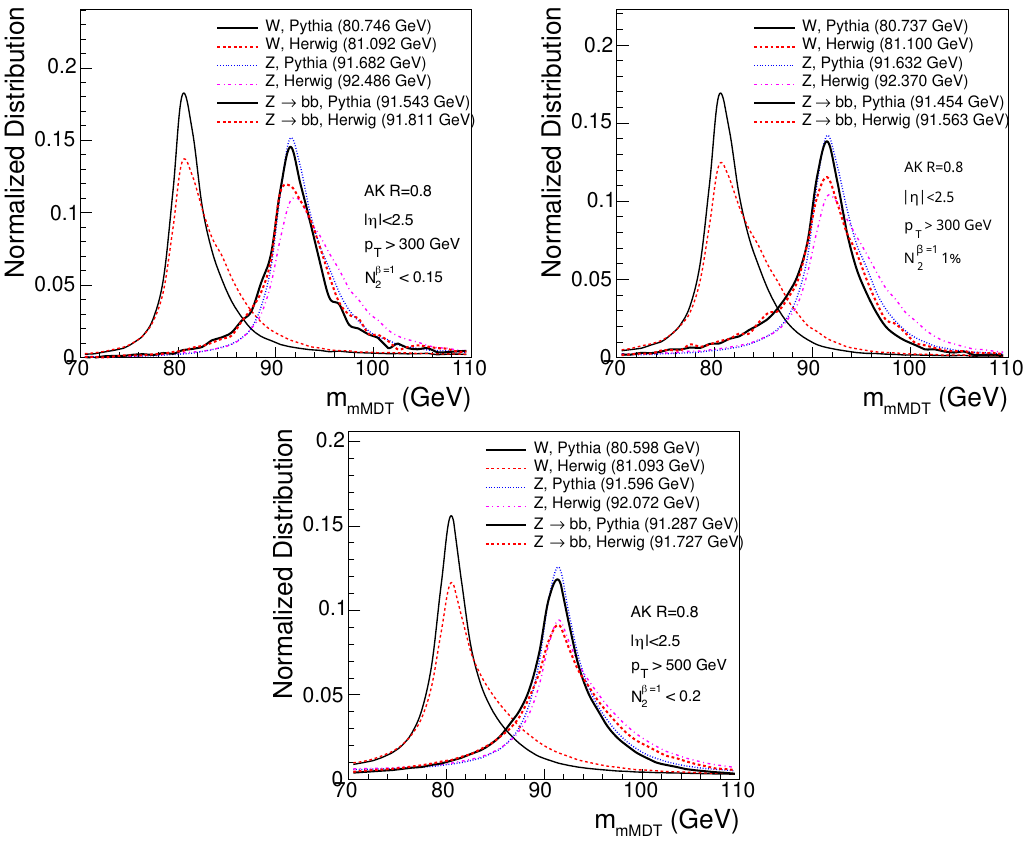
Figure 10 . Jet mass distribution of W , Z and Z ! b (cid:22) b jets in pythia and herwig using mMDT with the angular exponent (cid:12) = 0, soft cuto(cid:11) threshold z cut = 0 : 1, and characteristic radius R 0 = 0 : 8 for di(cid:11)erent selections on p T and N (cid:12) =1 300 GeV. (top right) decorrelated N (cid:12) =1 and p T larger than 500